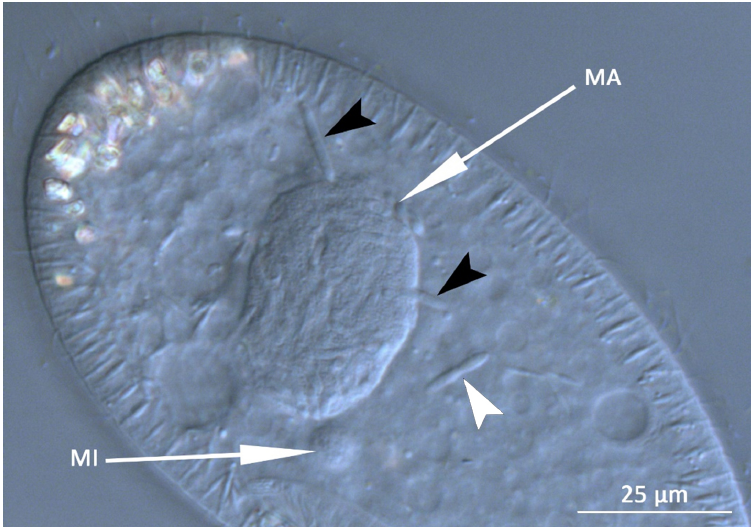
Figure 2. P. putrinum with bacteria in the macronucleus, individual infectious forms in the cytoplasm shown with black arrowheads, white arrowhead shows IF presumably undergoing a binary fission. MA—macronucleus, MI—micronucleus.